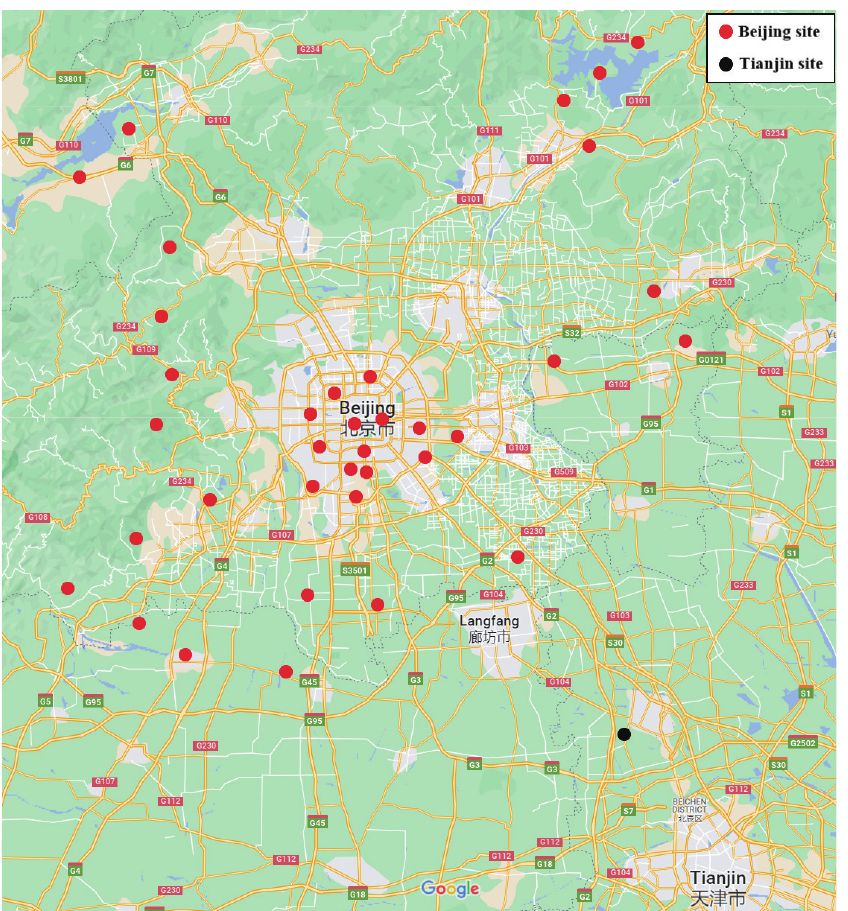
Figure 3. Distribution of monitoring sites in Beijing and Tianjin, the red points are all the sites in Beijing, and the black point is the Tianjin site to be